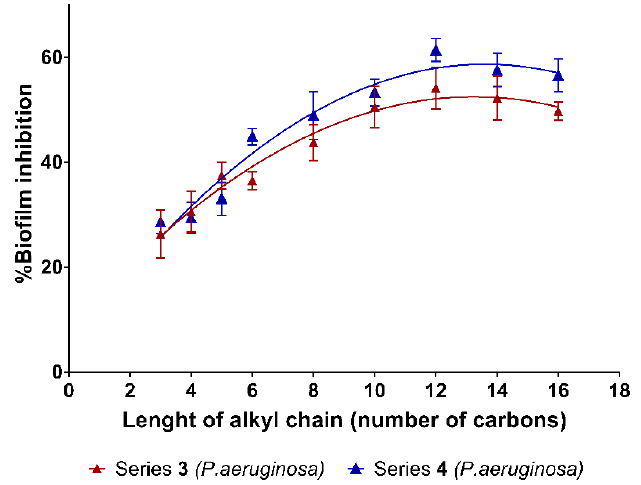
Figure 4. Plot of the percentage of biofilm inhibition in P.aeruginosa against the number of carbons in the alkyl chain.